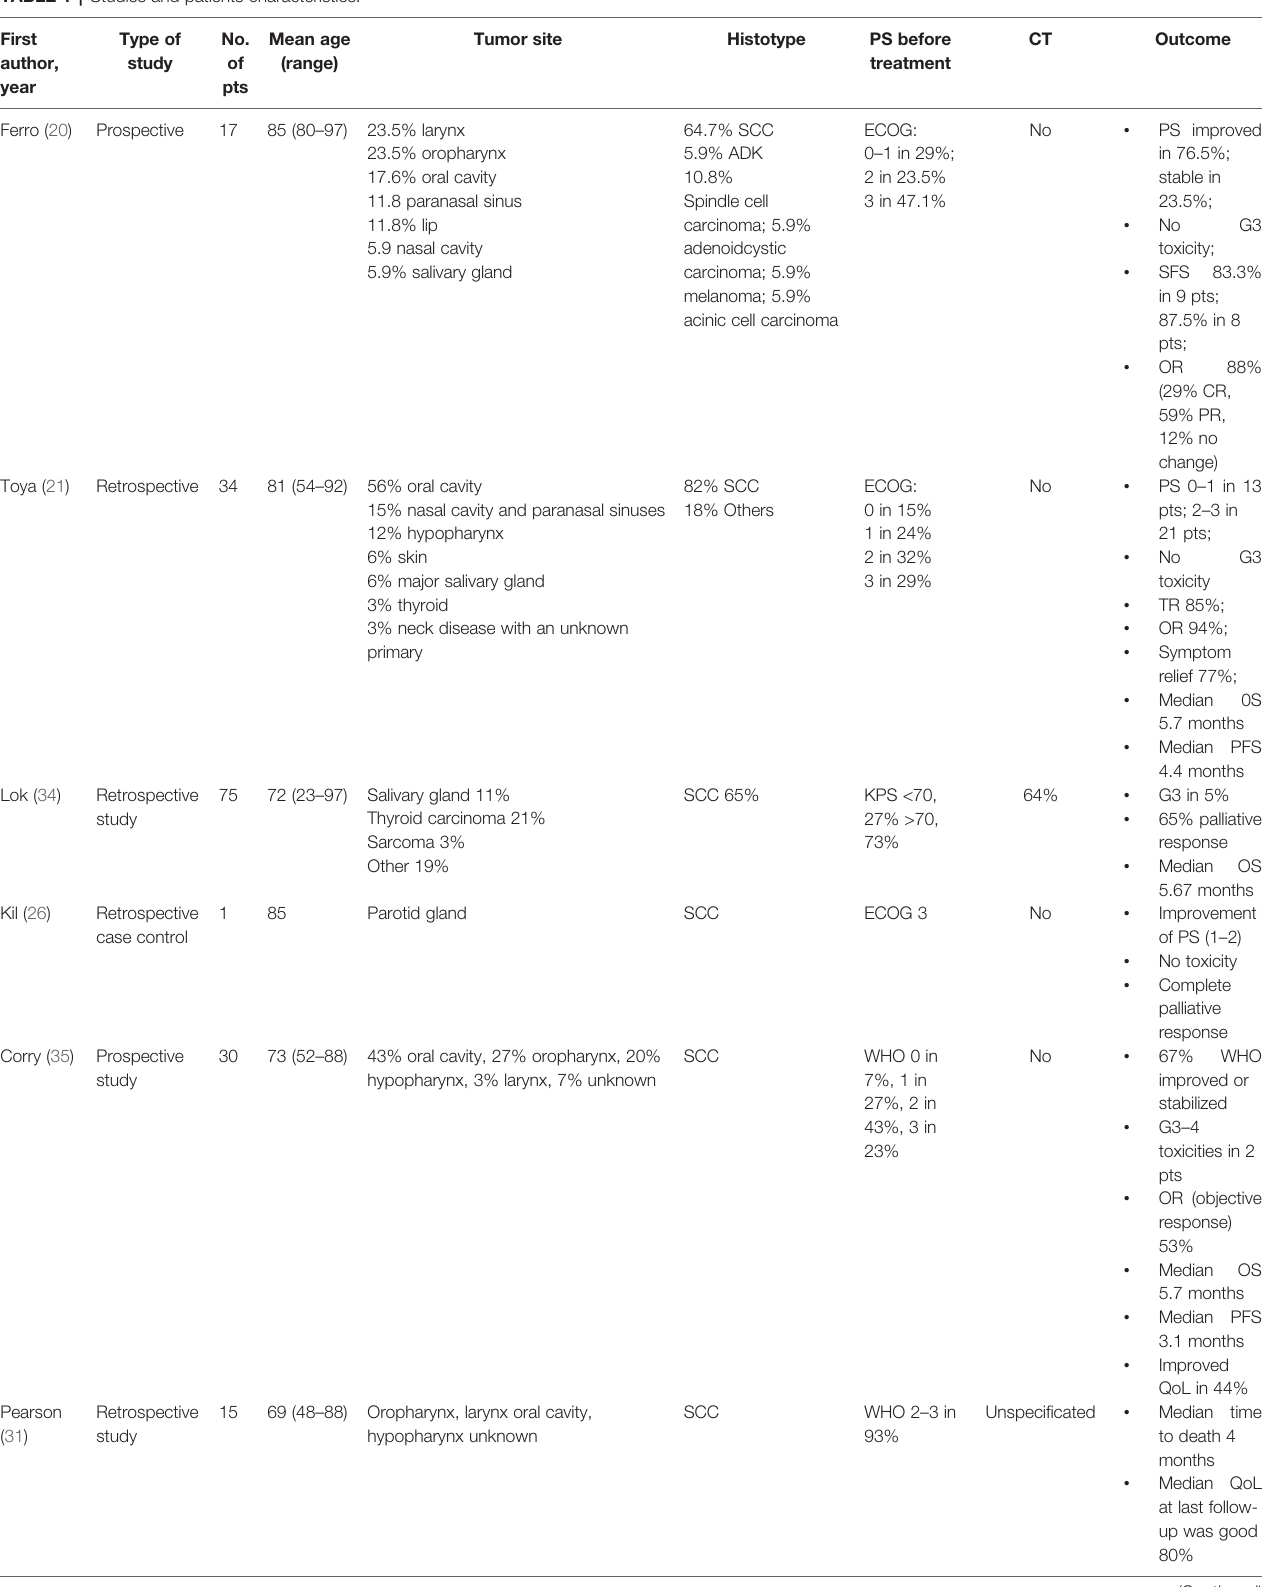
TABLE 1 | Studies and patients